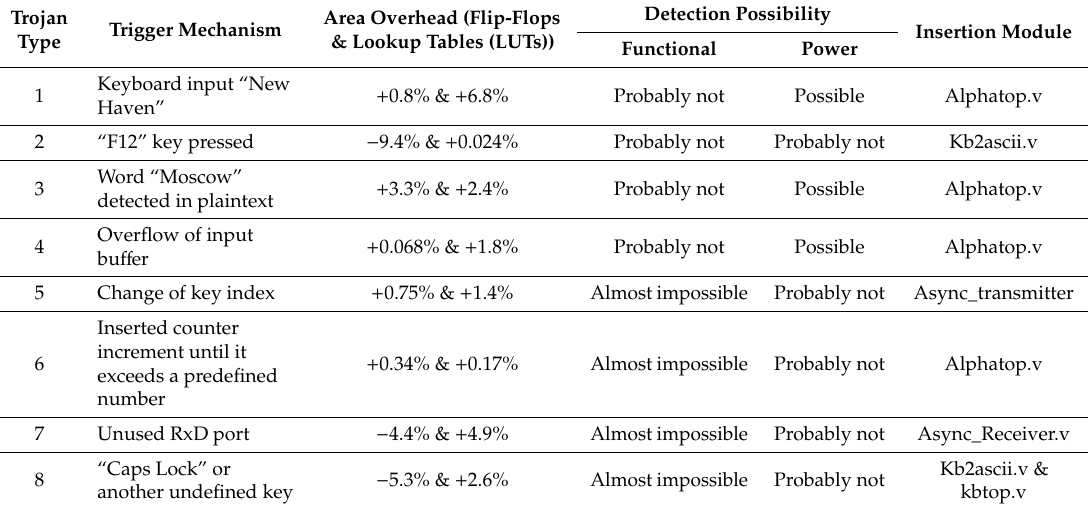
Table 1. Trojan types at RTL (Register Transfer Level) level with area overhead and detection possibility .